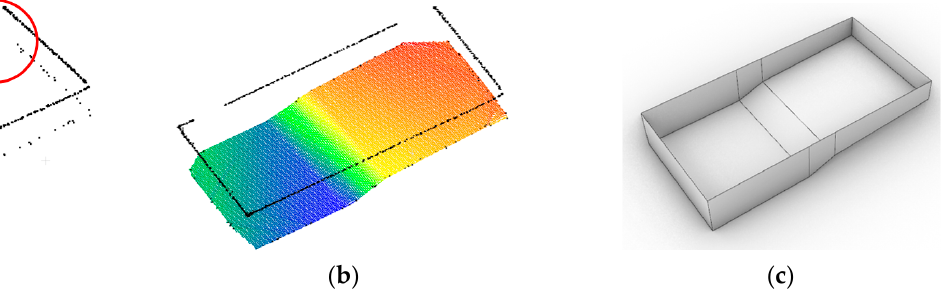
Figure 8. ( a ) Point cloud after synchronisation and correction operations; ( b ) interpolated pool bot- tom; ( c ) 3D model of the pool surveyed using traditional methods.